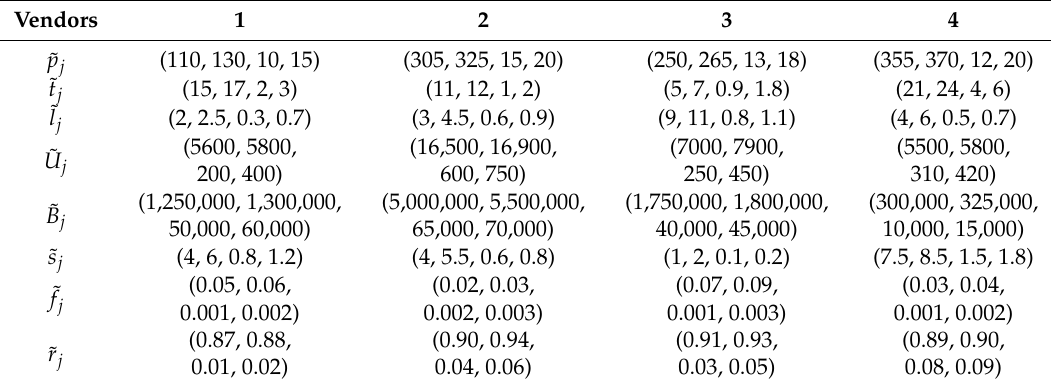
Table 4. Instance data for the Vendor Selection Problem with LR fuzzy numbers.